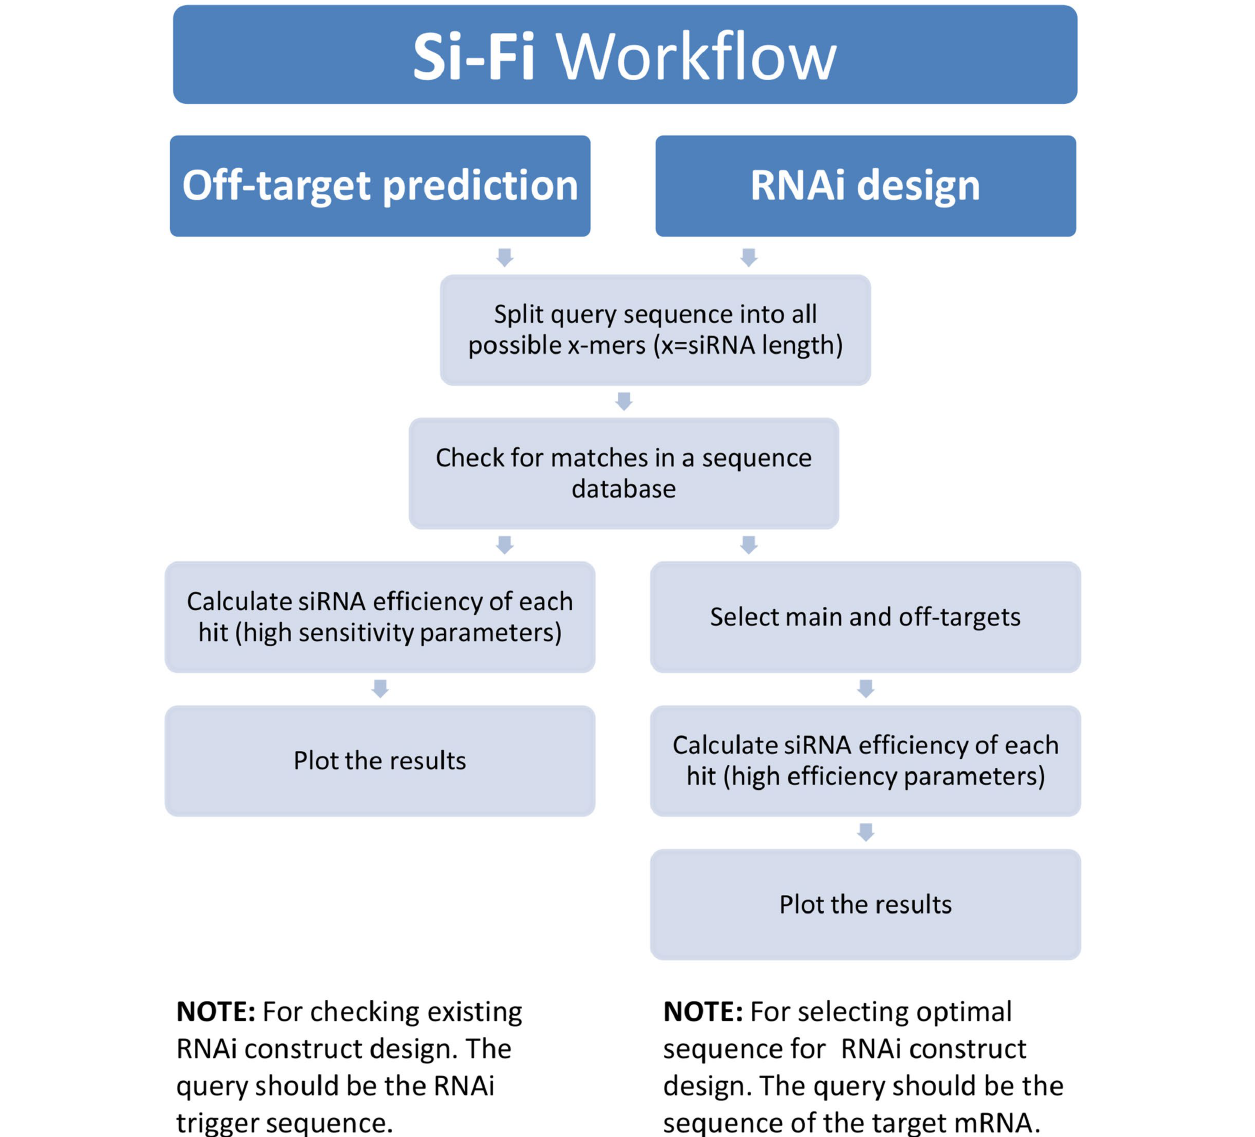
FIGURE 5 | si-Fi21 workflow diagram. The process begins with selection of the search mode. The off-target prediction is using the high-sensitivity (HS) mode settings for finding as many as possible putative off-targets as possible by minimizing the false-positive signals. The RNAi design is using the high-efficiency (HE) mode for detection of most effective siRNAs by avoiding the undesired